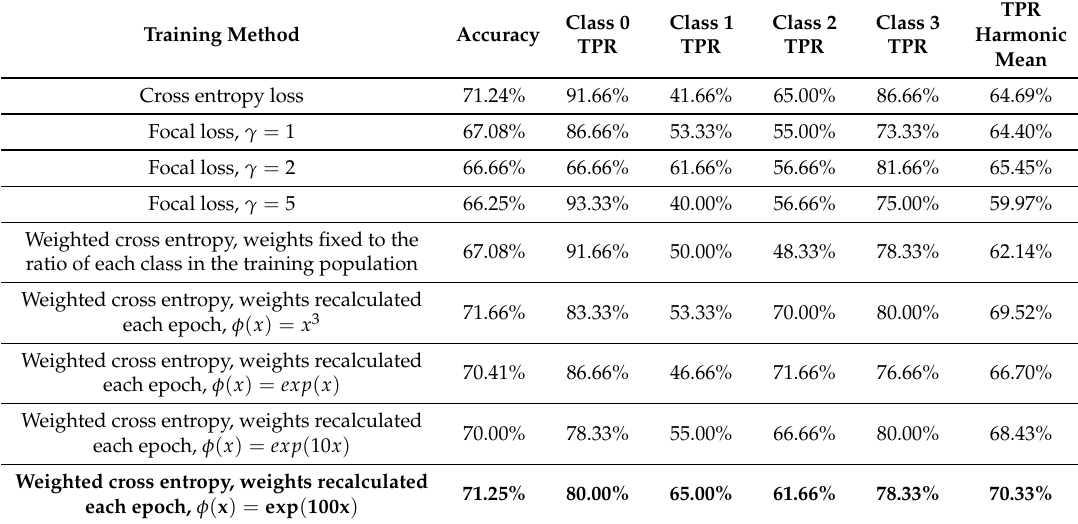
Table 8. Results for experiments regarding dataset imbalance. We used the MobileNetV2 tuned model as described in Section 3.2.2 and the images involving an acetic acid solution. TPR stands for true positive